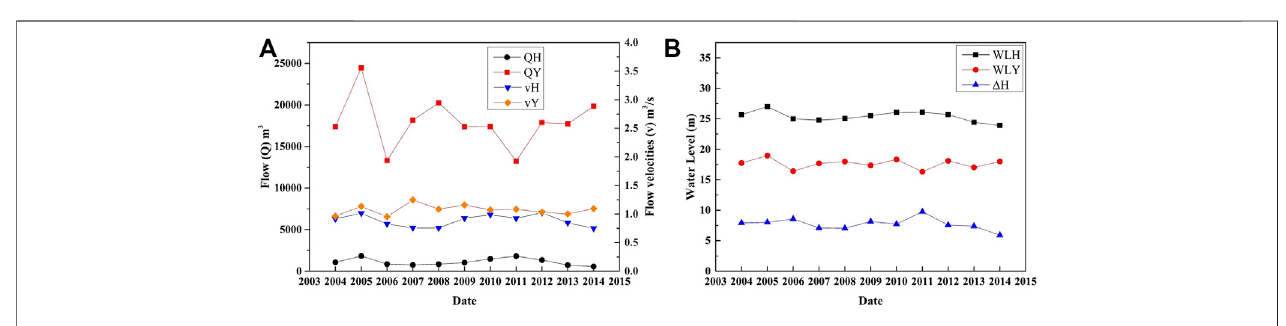
FIGURE 3 | Hydrological regime in the lower HR.